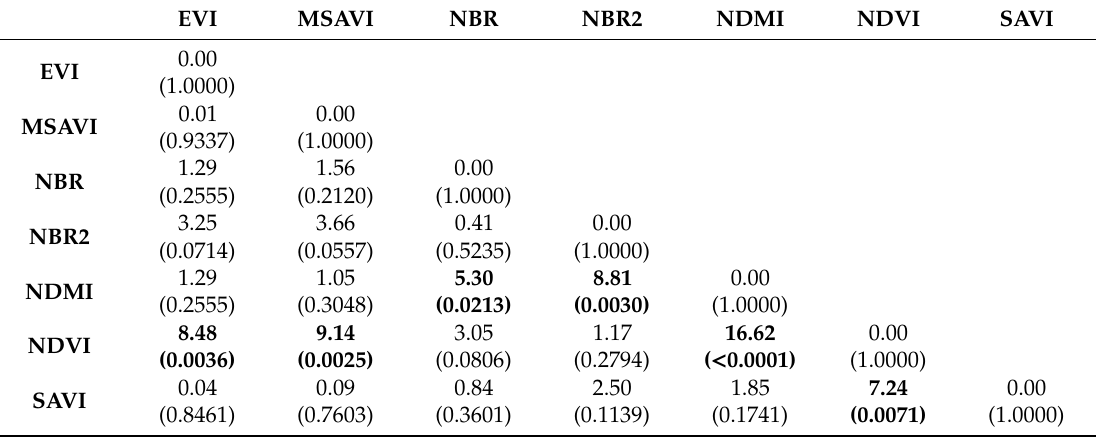
Table 3. Comparison of spectral indices disturbance accuracies using McNemar’s test in semi-arid woodland vegetation domain. The upper number indicates the chi-squared value, the number in parentheses indicates the p -value, and bold values indicate statistical